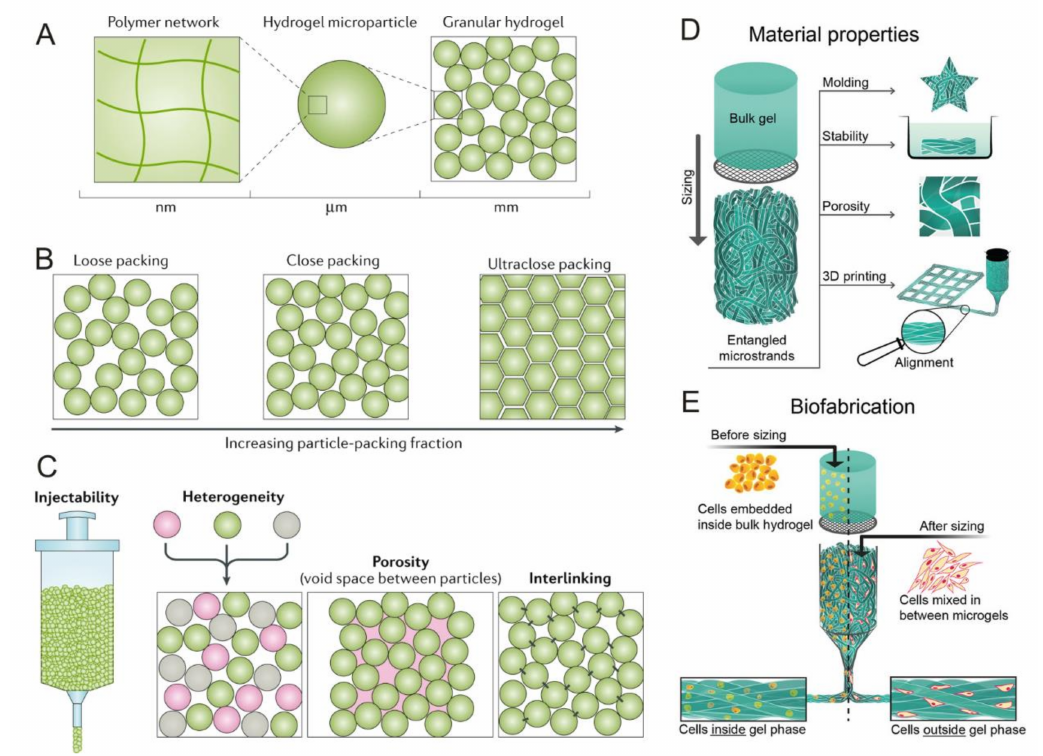
Figure 6. Schematics illustrating the structure and properties of granular hydrogels made from ( A – C ) microspheres and ( D , E ) entangled microstrands. ( A ) Granular hydrogels are made up of hydrogel microparticles (HMPs), which are typically made up of crosslinked polymer networks. ( B ) HMPs within the granular hydrogels can have different types of packing, including loose, close, and ultraclose. ( C ) Granular hydrogels have properties including injectability, heterogeneity (formed from mixtures of different types of HMPs), porosity between the HMPs, and ability for the HMPs to be linked together. ( D ) The process of making entangled microstrands from a bulk hydrogel involves extruding it through a grid. These microstrands can form stable and porous granular hydrogels and can be shaped by molding or 3D printing. ( E ) Bioinks can be prepared by interlaying cells in the hydrogel either before or after the microstrands are created from the bulk hydrogel. ( A – C ) Reproduced with permission from [115]. © 2021 Springer Nature Limited. ( D , E ) Reproduced under the terms of